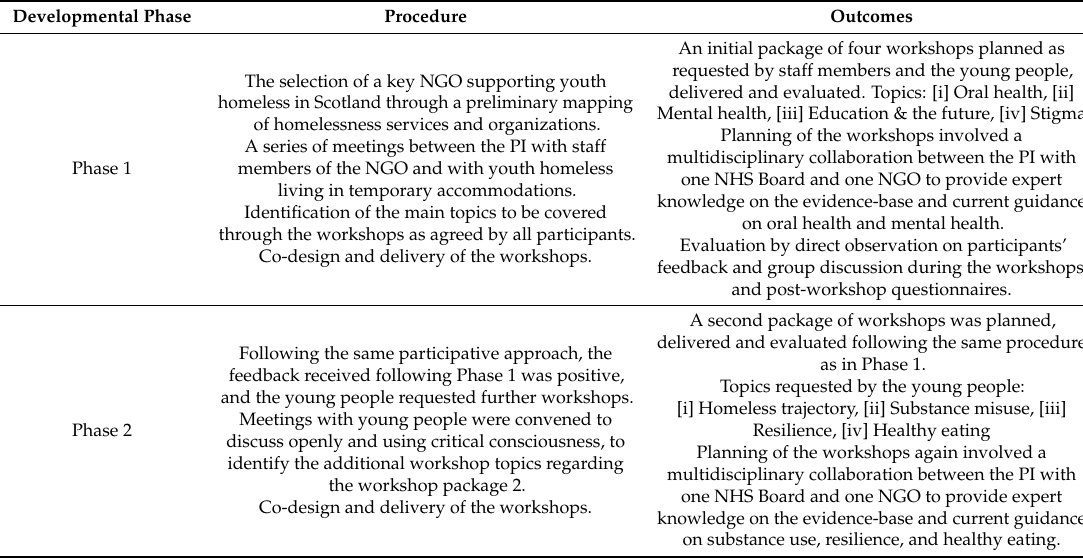
Table 1. Pedagogical workshop